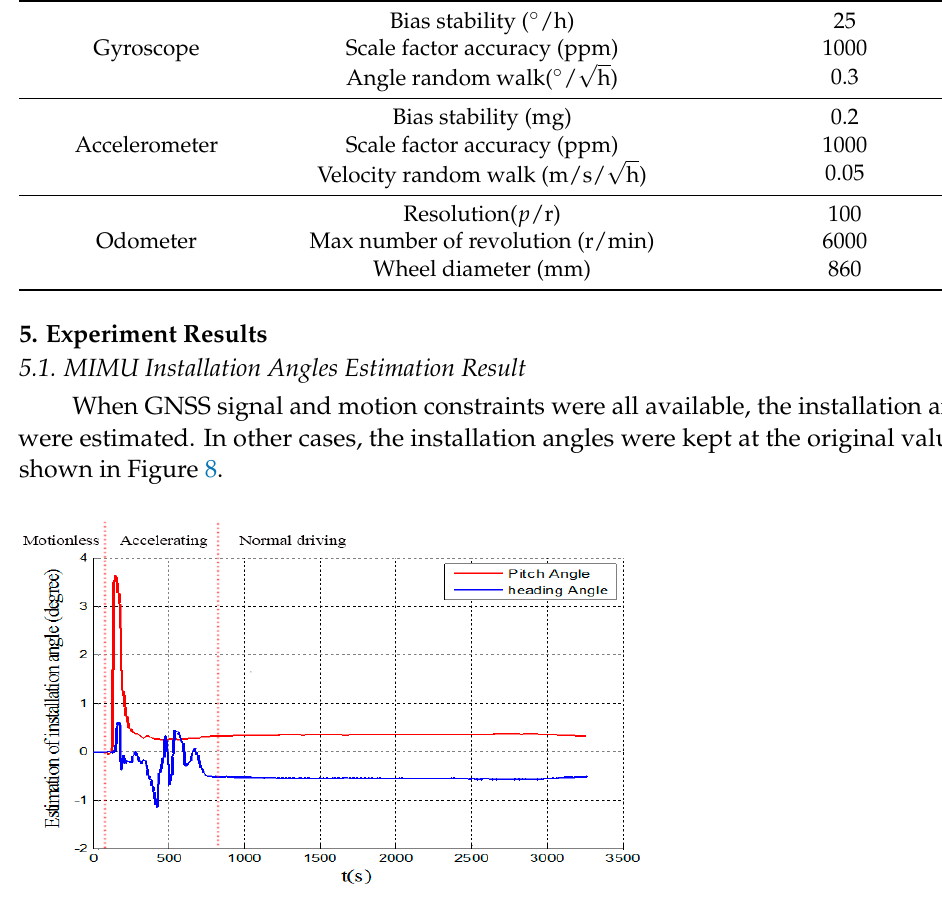
Figure 8. MIMU installation angles.